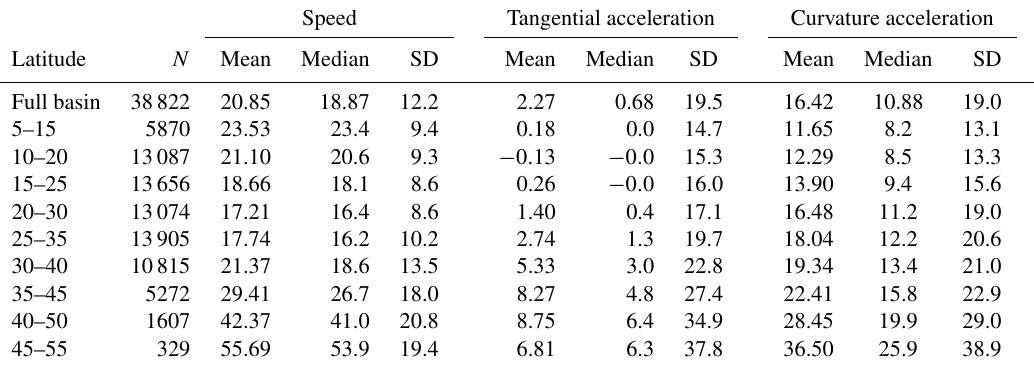
Table 1. Speed (kmh − 1 ), tangential, and curvature acceleration (kmh − 1 d − 1 ) of Atlantic TCs in the IBTrACS database as a function of latitude. Storm instances classified as ET or NR were excluded. N refers to the number of 3-hourly track positions in each latitude bin over the period